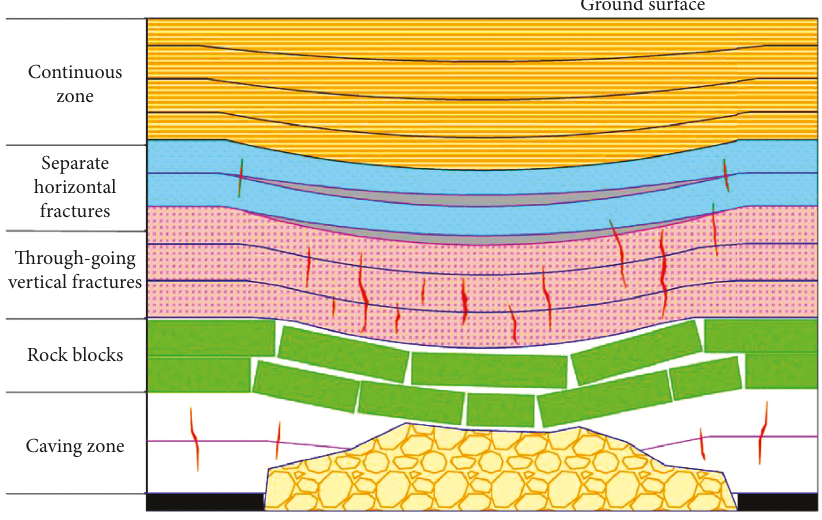
Figure 1: Illustration of the five-zone theory on overlying rock vertical Table 1: Some part of advancing progress of working face #22517.